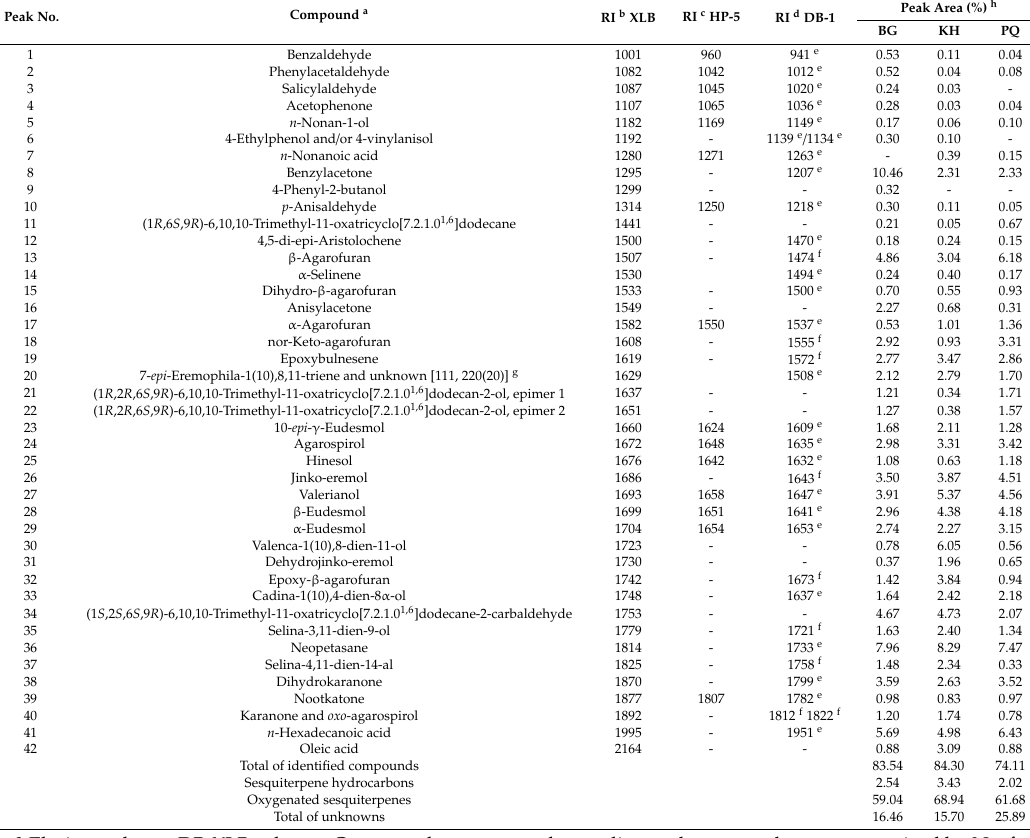
Table 1. Constituents of essential oils obtained from agarwood samples produced by A. crassna growing in the provinces Bac Giang (BG) and Khanh Hoa (KH), and on the island Phu Quoc (PQ) of Vietnam. PeakNo. Compound a RI b